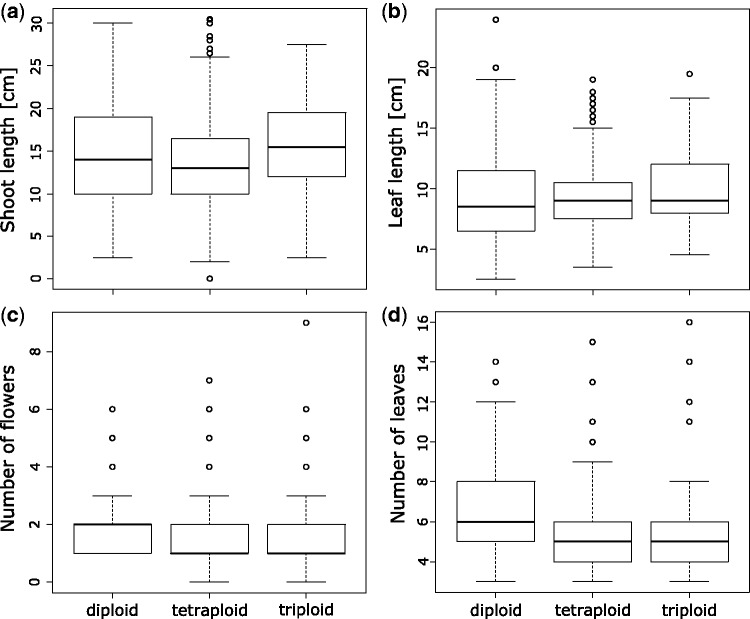
Boxplots of field collected fitness parameters on individual level of Ranunculus kuepferi cytotypes. Outliers are presented as black circles (o). (a) Total length of main shoots from ground to flower base, respectively fruit base. (b) Length of the longest leaf per plant. (c) Total number of flowers, respectively buds or fruits, per plant. (d) Total number of ground and shoot leaves per plant.